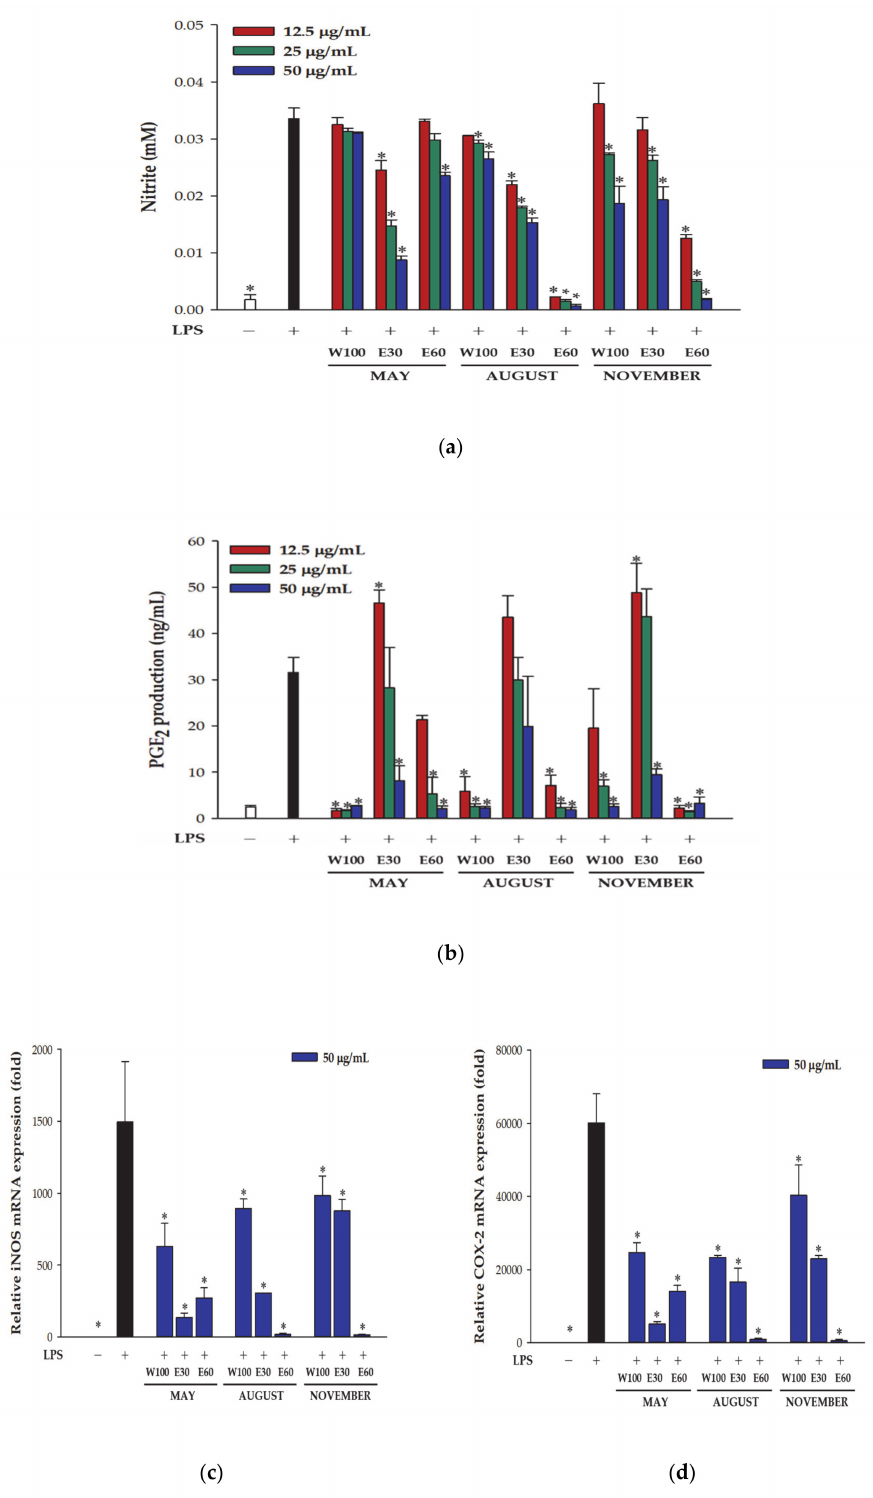
Figure 3. E ff ects on the production of nitrite ( a ), prostaglandin E 2 ( b ), mRNA expression levels of inducible nitric oxide synthase ( c ), and cyclooxygenase-2 ( d ) in the RAW264.7 cells stimulated with lipopolysaccharide. W100, hot water extracts; E30, 30% ethanol extracts; and E60, 60% ethanol extracts. Data are presented as the mean ± SEs of triplicate determinations of independent wells. Statisticalanalysiswasperformedusingone-wayANOVA.*, p < 0.05comparedtothelipopolysaccharide (LPS)-treated